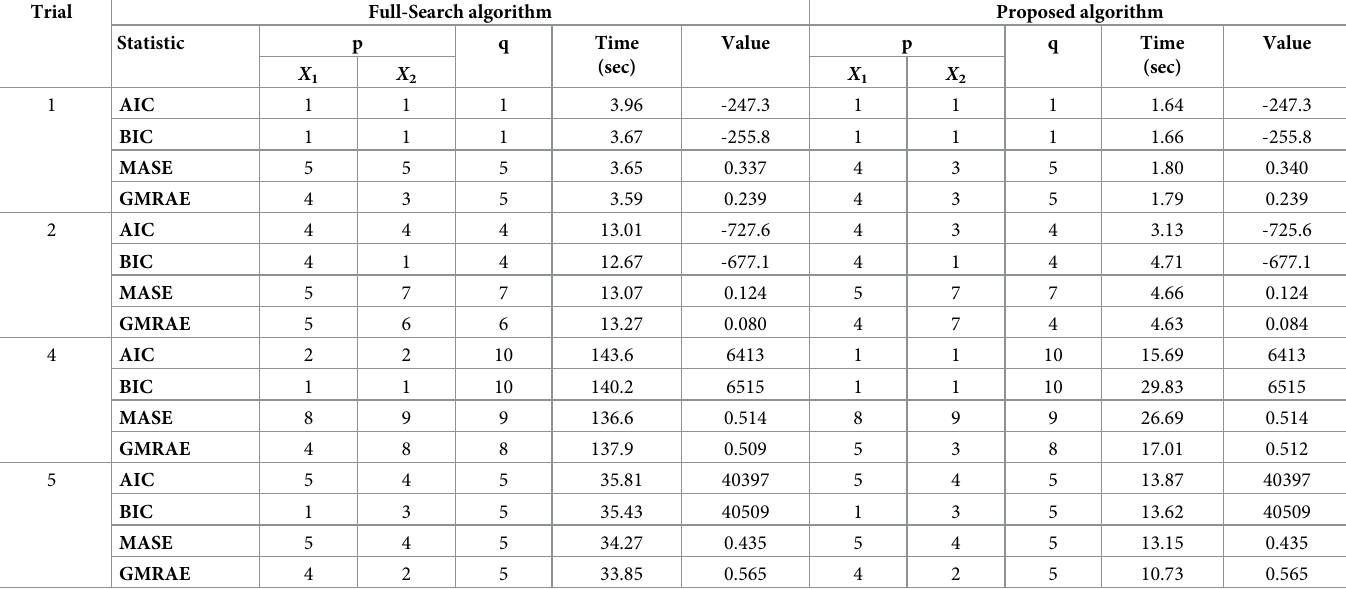
Table 2. Benchmarking of p and q lag orders, implementation time, and the value of GOF statistic for the full-search and the proposed algorithm for Trials 1, 2, 4, and 5.